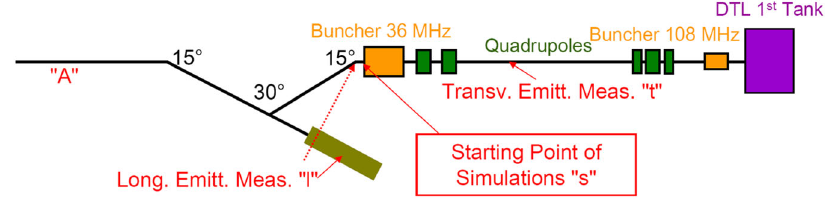
FIG. 6. (Color) Reference points used for reconstruction of the initial phase space distribution as needed for the